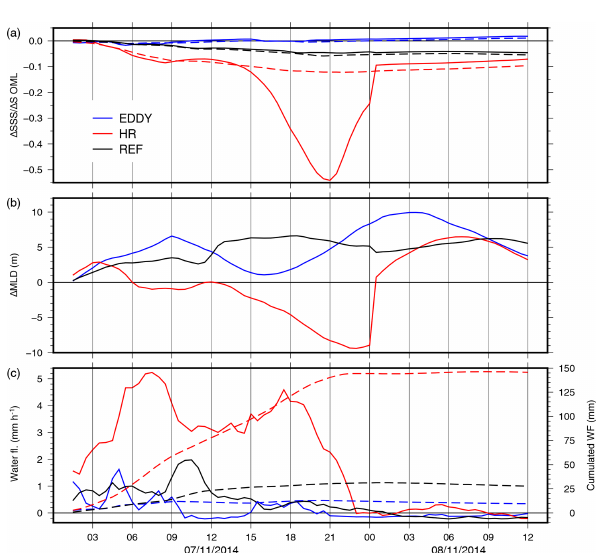
Figure 13. Time series of the SSS (solid line) and mean salinity in the OML (dashed line, a ), MLD (b) , and instantaneous (solid line, left-hand-side scale) and integrated water flux (dashed line, right- hand-side scale) (c) in the EDDY (blue), HR (red), and REF (black) zones (see